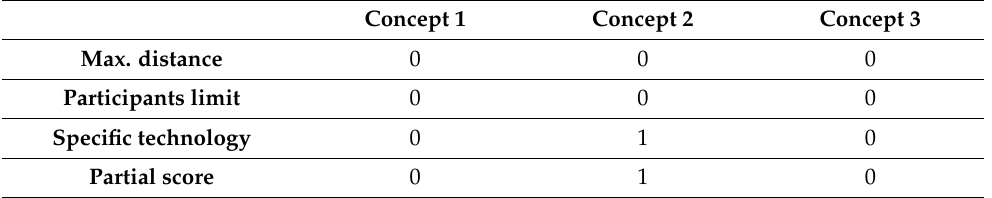
Table 15. Scalability potential—first partial score. Attributes affecting the scalability potential.